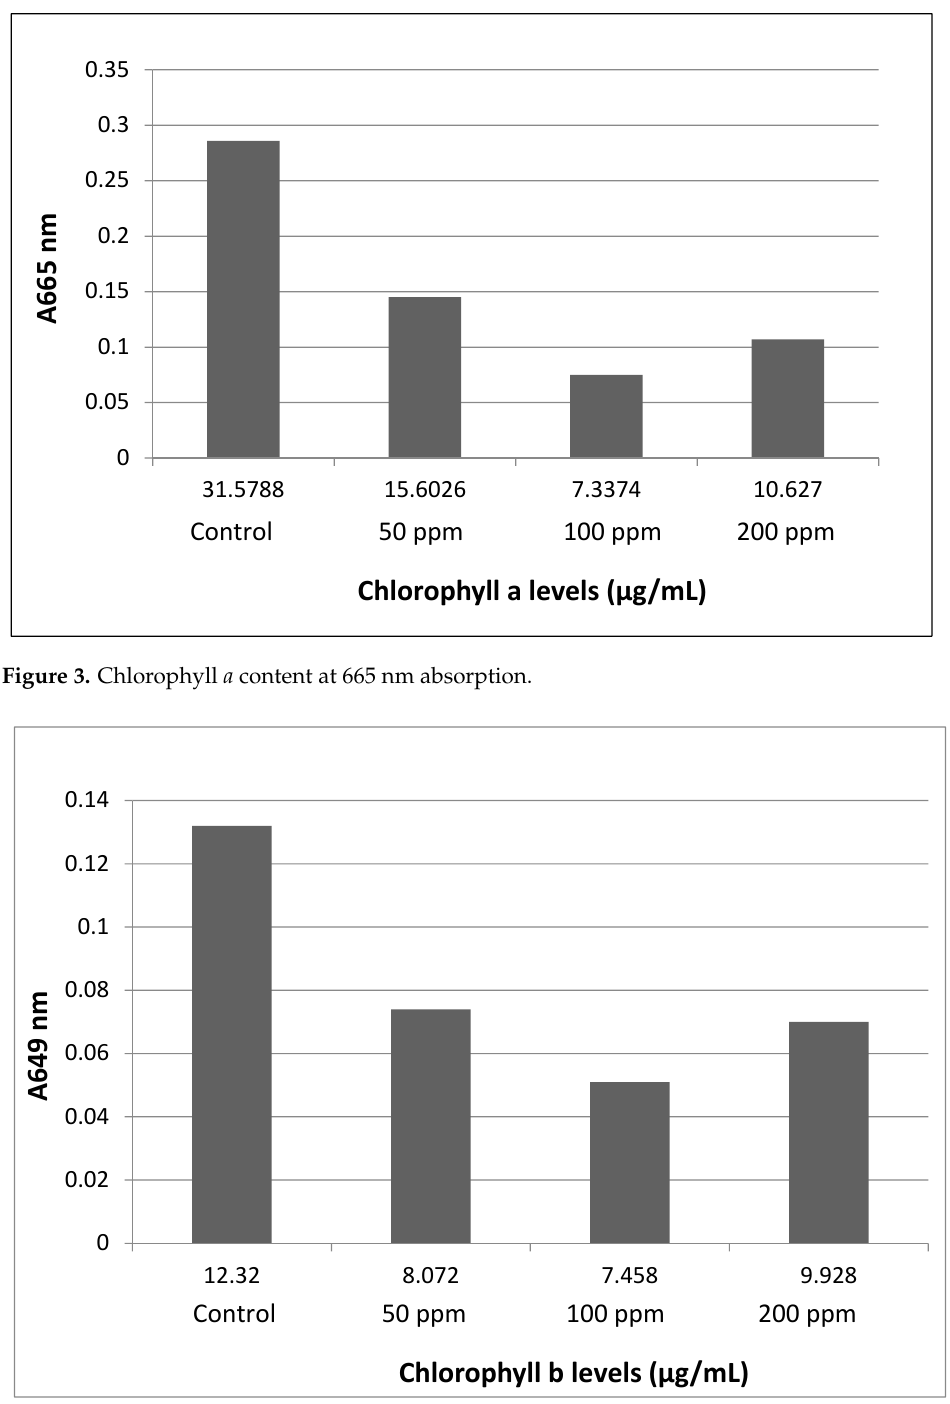
Figure 4. Chlorophyll b content at 649 nm absorption.